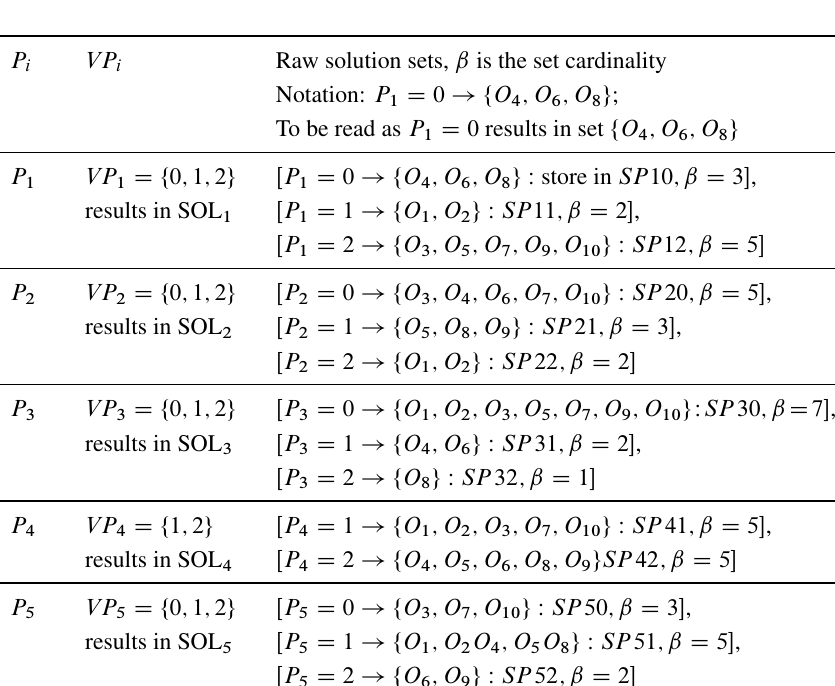
Table 1. Example information system.